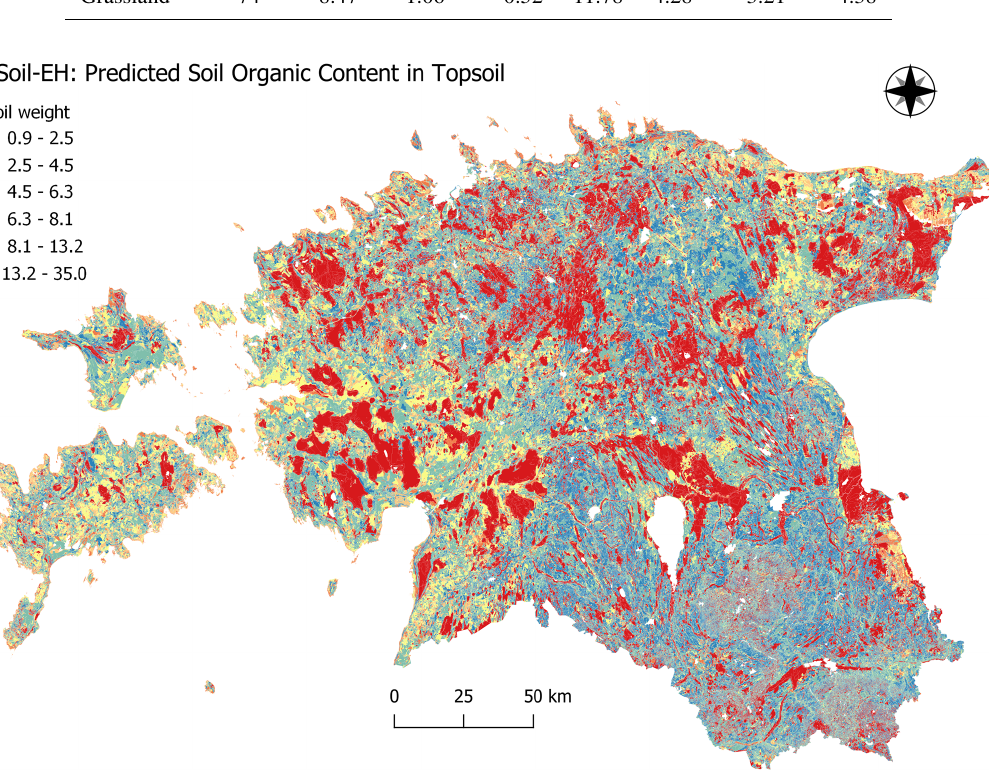
(i.e. soil reference group), texture class, soil profiles (e.g.